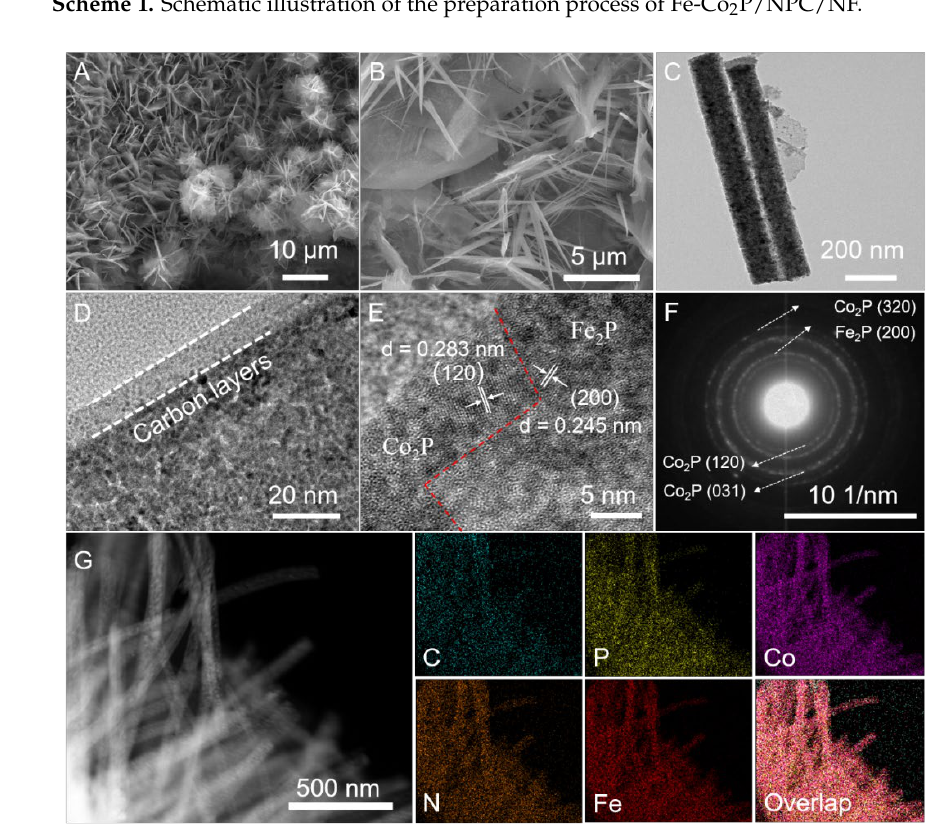
Figure 1. ( A , B ) SEM images, ( C , D ) TEM images, ( E ) HRTEM image, ( F ) SAED patterns, and ( G ) HAADF-STEM image and EDS mapping of the Fe-Co 2 P/NPC/NF catalyst. The crystal phases of the Fe-Co 2 P/NPC/NF catalyst were investigated by X-ray diffrac- tion (XRD). As shown in Figure 2B, the characteristic peaks at 42.5 ◦ , 43.3 ◦ , 44.1 ◦ , 50.4 ◦ , 52.0 ◦ , and 56.2 ◦ correspond to the (220), (211), (130), (310), (002), and (320) crystal planes of Co 2 P (PDF#32-0306), respectively. In addition, three characteristic peaks at 40.3 ◦ , 47.2 ◦ , and 54.6 ◦ confirm that the (111), (210), and (211) crystal planes of Fe 2 P (JCPDS#83-2337) were also formed in the Fe-Co 2 P/NPC/NF catalyst (Figure 2A shows the precursor of Fe-doped CoO 2 ). It is important to investigate the composition and surface chemical state